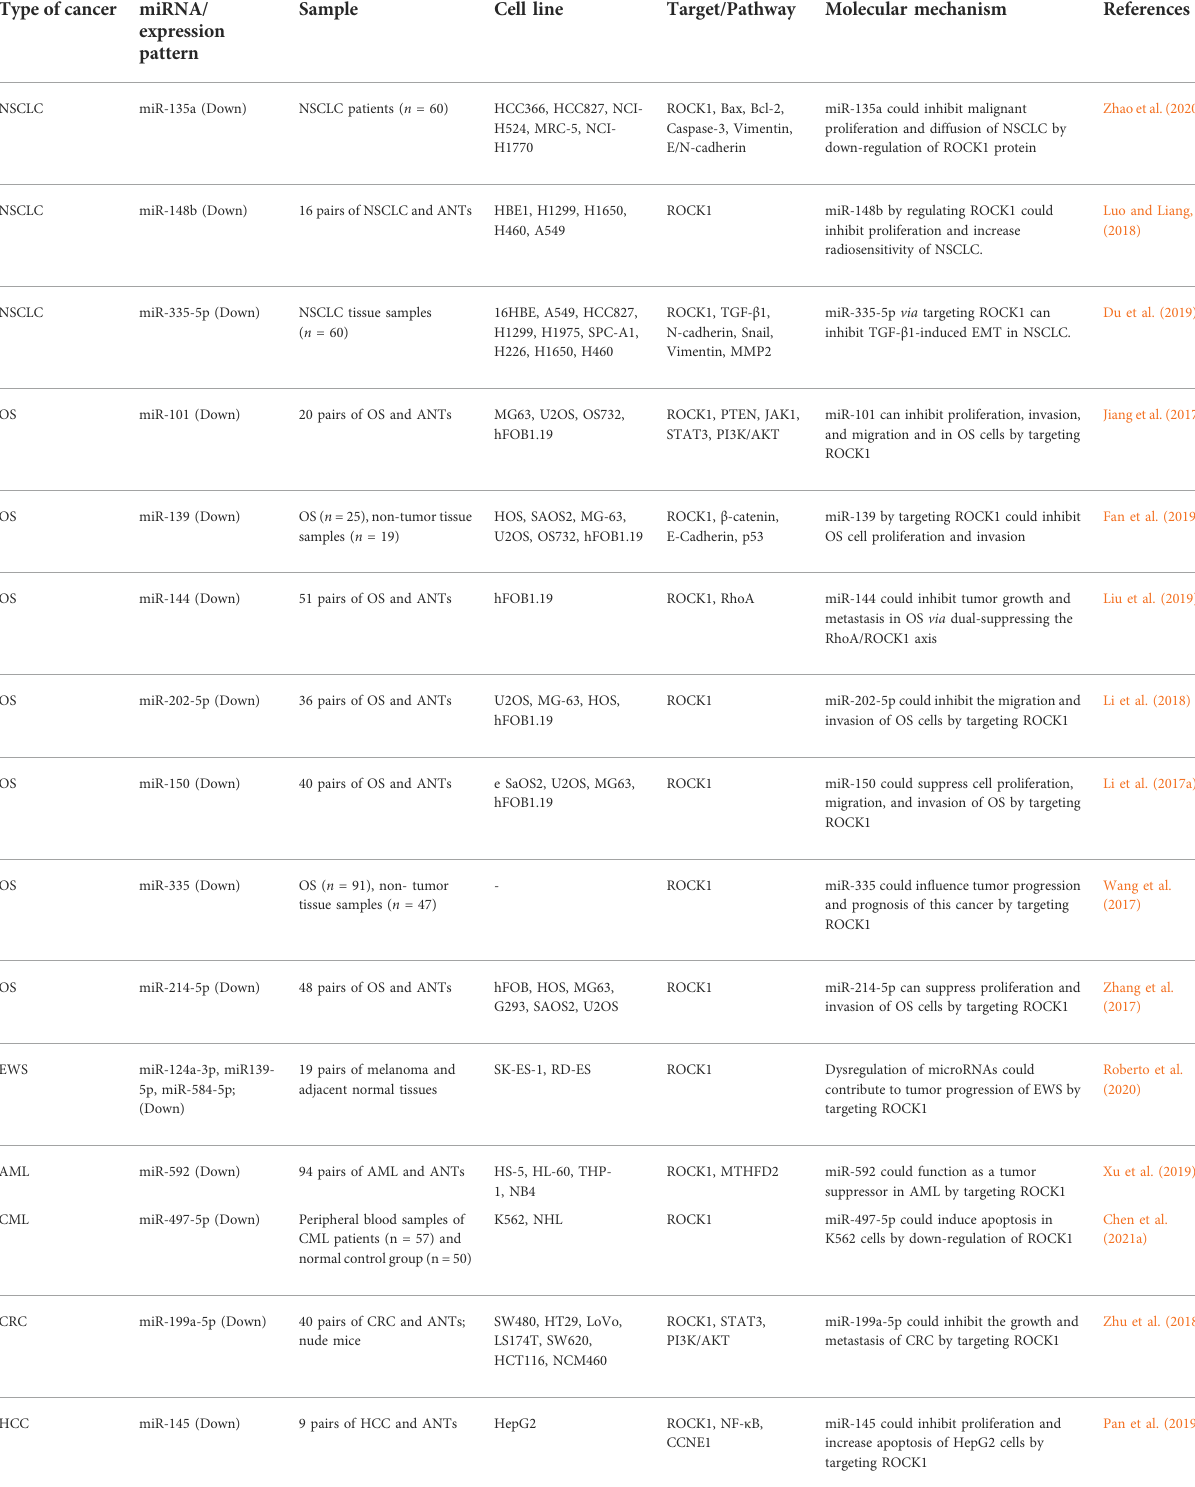
TABLE 2 ROCK1-interacting miRNAs in cancers (ANTs: adjacent non-cancerous tissues, NSCLC: non-small cell lung cancer, OS: osteosarcoma, EWS: Ewing sarcoma, AML/CML: acute/chronic myeloid leukemia, HCC: hepatocellular carcinoma, CRC: colorectal